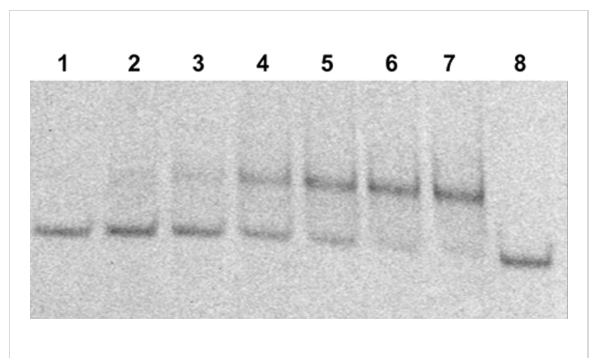
Figure 16: Non-denaturing gel electrophoresis analysis of conjugate 28 with fluorescein-labeled target HIV duplex (concentration 120 nM), polyamide concentrations: 0, 0.45, 0.75, 1.13, 1.5, 2.25, 3, 0 μ M (lines 1 to 8, respectively) in 0.05 M HEPES, 50 mM NaCl, 5 mM MgCl 2 , pH 7.2. Visualization of the gel was performed by monitoring fluores- cence of the fluorescein-labeled duplex depicted in Figure